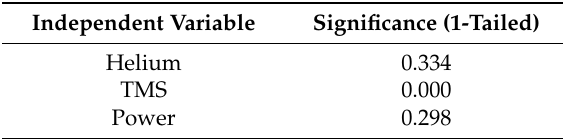
Table 7. Significance of the model parameters.